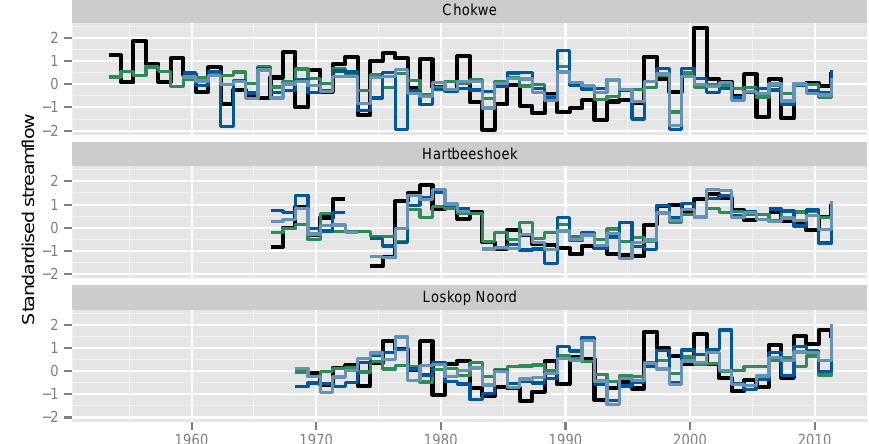
Figure 10. Hindcasted time series of DJFMAM forecast models at a lead time of 1 month (November forecast) of stations Chokwe with low skill, Hartbeeshoek with good skill and Loskop Noord with medium skill. The presented time series are the cross-validated, thus independent, results of the MLM (light blue), ANN (dark blue) and RFOR (green) models. Observed standardised streamflow is shown by the underlying black